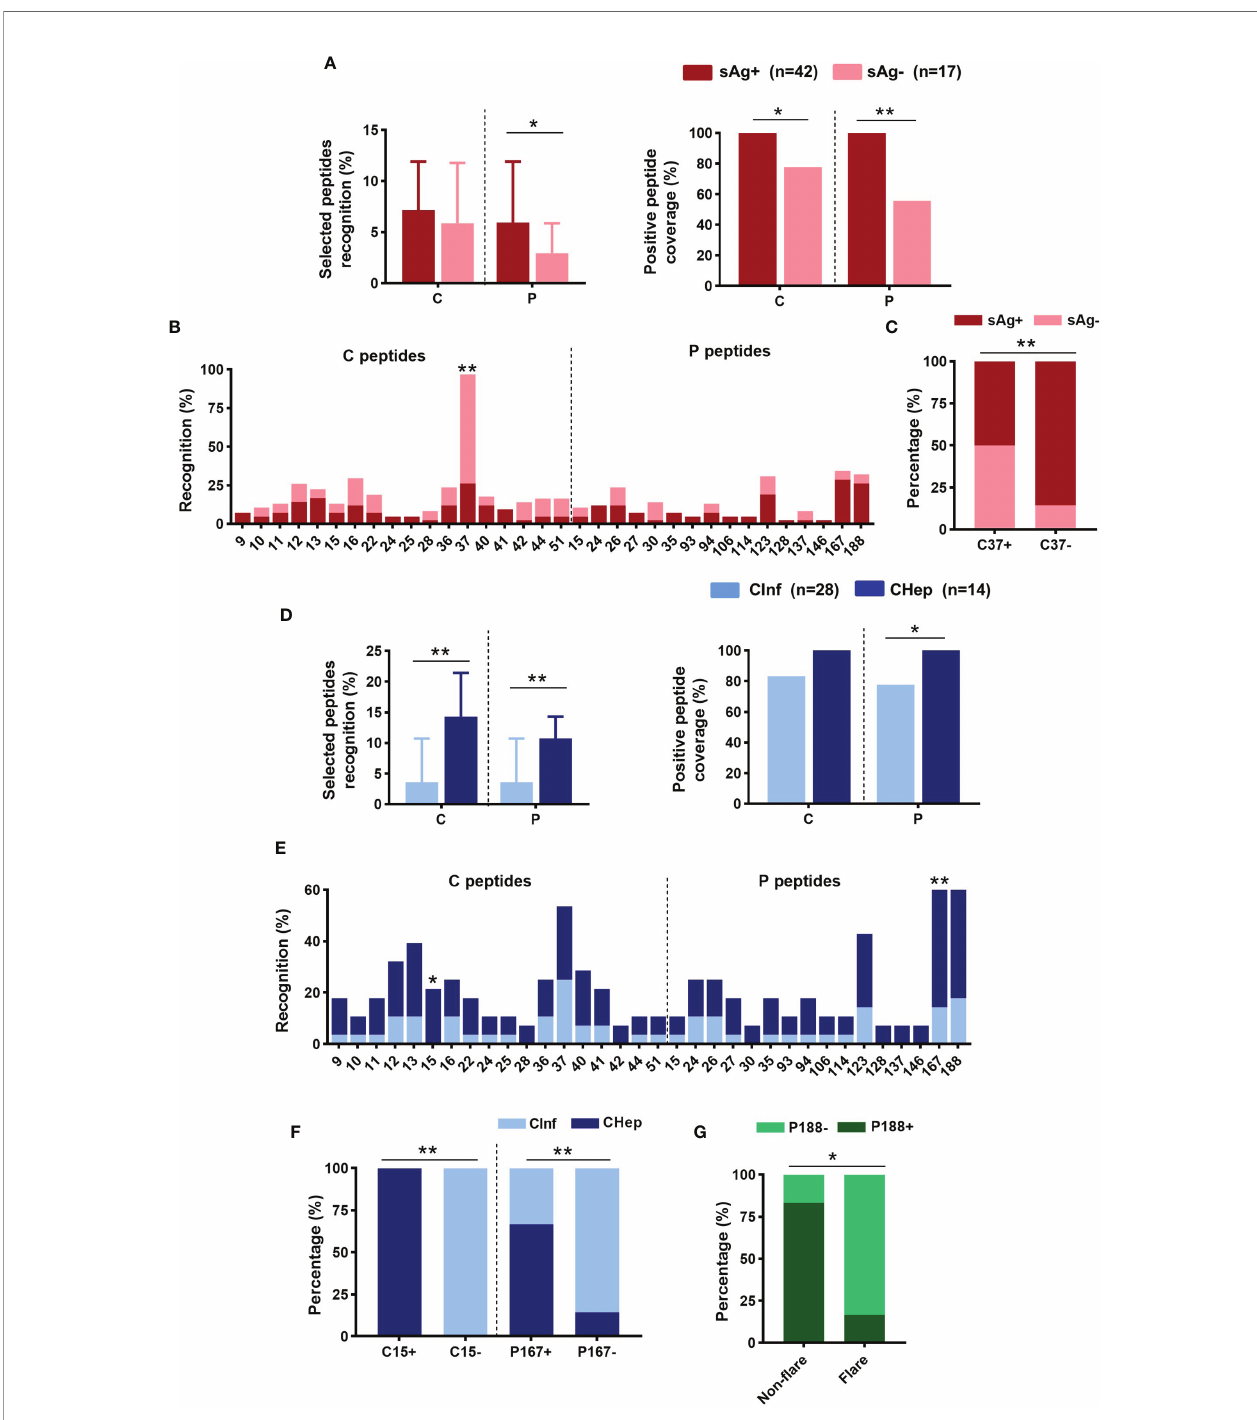
FIGURE 6 | Distribution of linear B-cell epitopes on core (C) and polymerase (P) proteins. (A) Comparison of the recognition rate and positive peptide coverage on C or P between sAg + and sAg - groups. (B) The recognition rate of the selected peptide on C or P. (C) Proportion of patients with detectable sAg or sAg loss in the C37+/- group. (D) Comparison of the recognition rate and positive peptide coverage on C or P proteins between CInf and CHep patients. (E) Comparison of the recognition rate of the selected peptides between CInf and CHep patients. (F) The proportion of patients with CInf or CHep in the C15+/- or P167+/- groups. (G) The proportion of P188 was positive or negative in the ALT non fl are and fl are phases of those six patients. (A, D) Mann – Whitney U test (left) and Chi-square test (right). (B, C, E – G) Chi-square test. * P < 0.05, ** P <